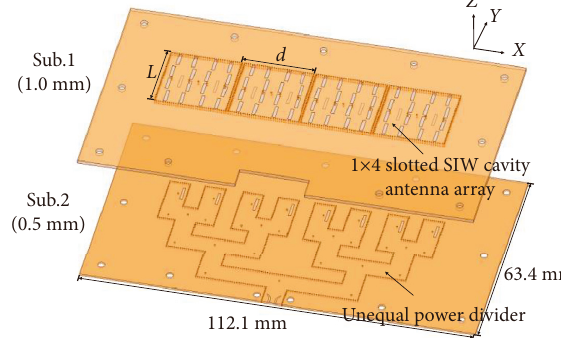
Figure 1: Configuration of the proposed antenna